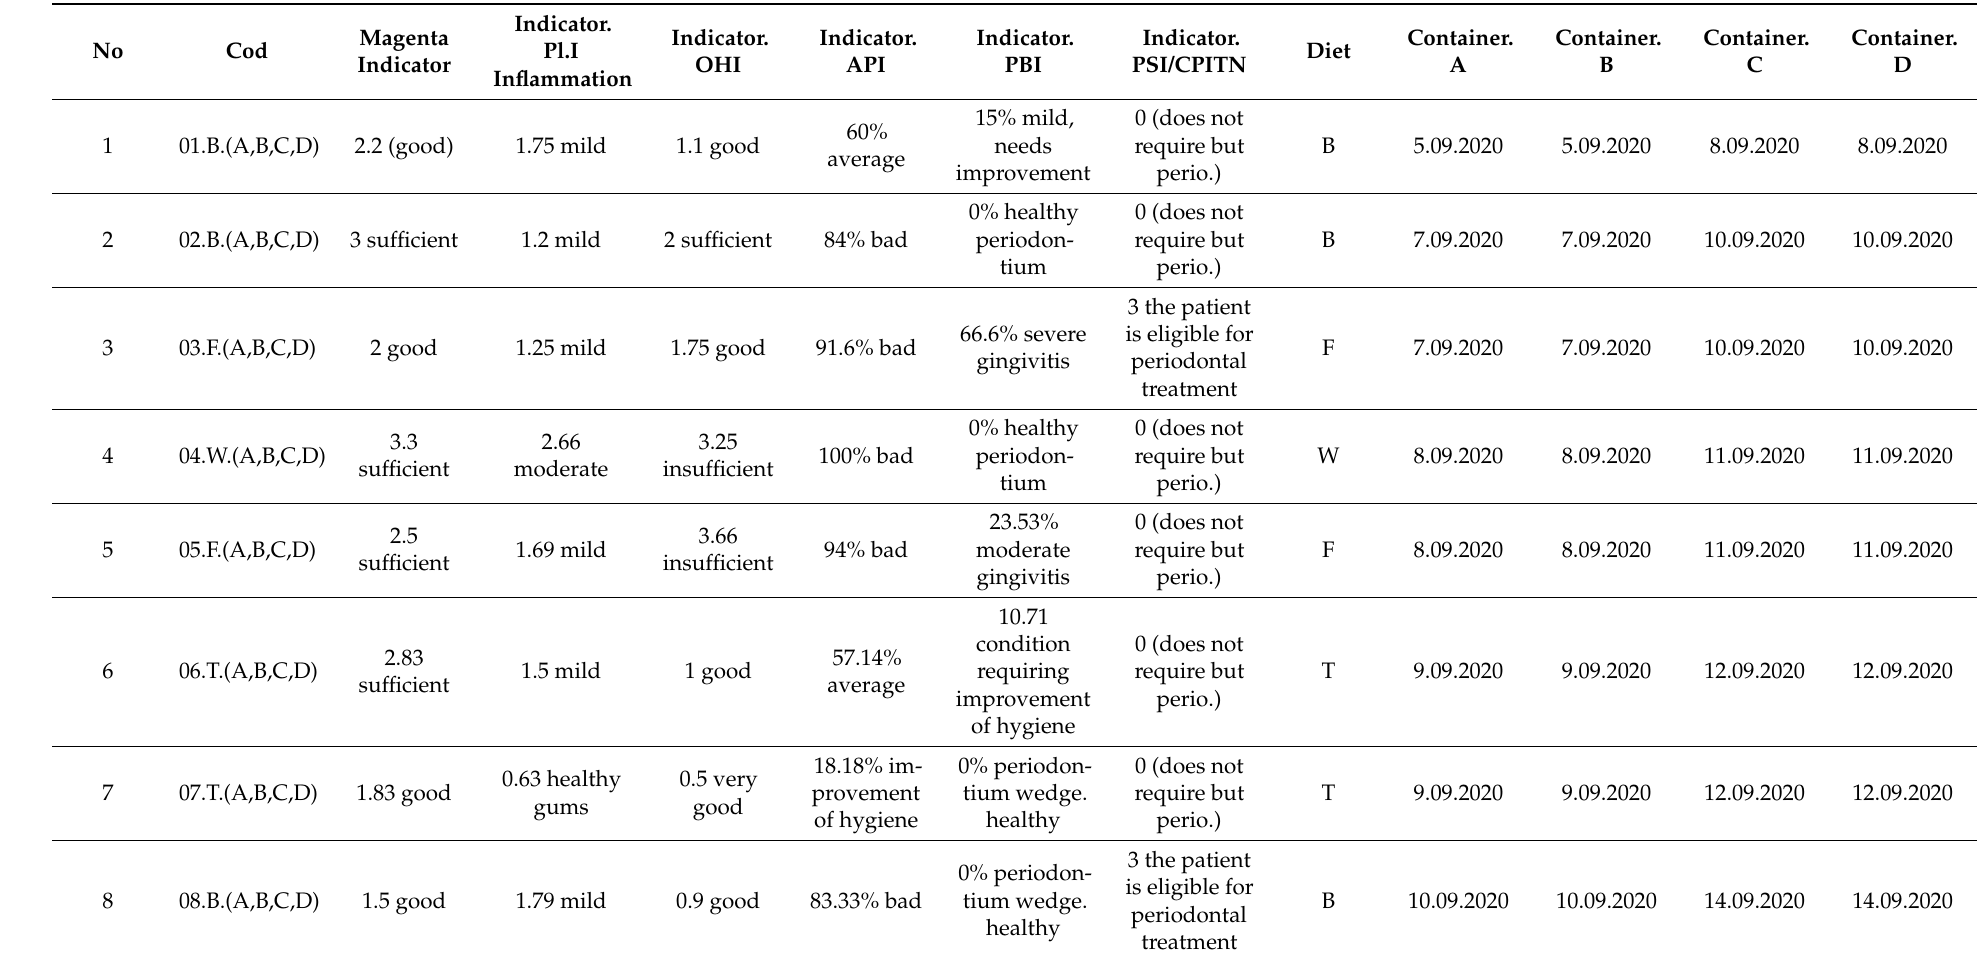
Table 2. Dental indicators will be used to assess the presence and location of bacterial plaque and tartar in the oral cavity and to determine the needs of specialist treatment—periodontics. The presence of residual bacterial plaque and tartar is a determinant of the presence of inflammation of soft tissues, very often chronic inflammation. The results will be used for further research analysis and for